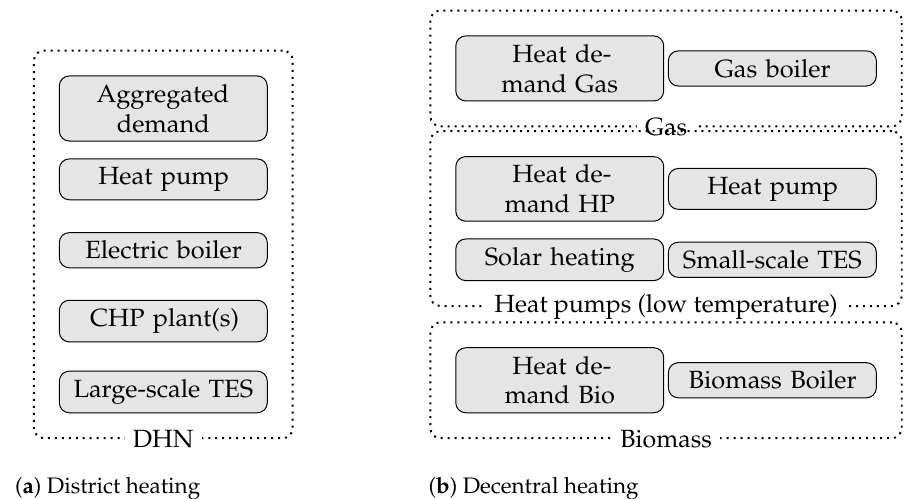
Figure 3. Conceptual approach to modeling decentral and district heating on aggregated nodal